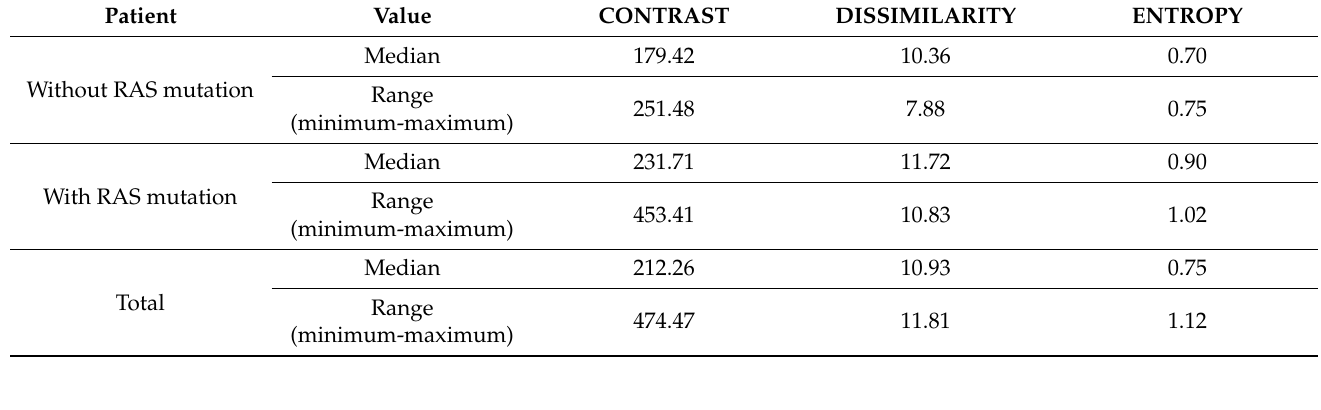
Table 4. Median and range values for the radiomic extracted metrics.